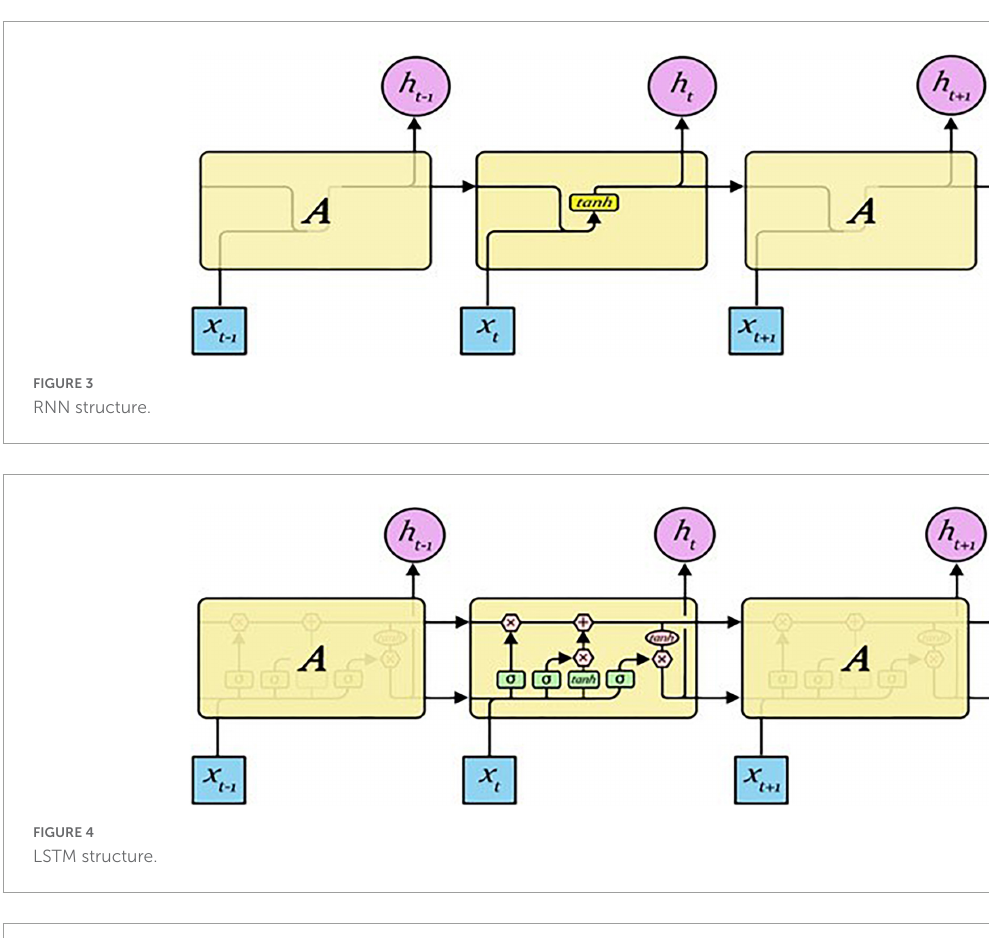
linkage library (tokenizer = BertTokenizer.from_pretrained, model = TFBertModel.from_pretrained). Figure 5 shows schematic diagrams of the BERT overall pre-training and fine-tuning